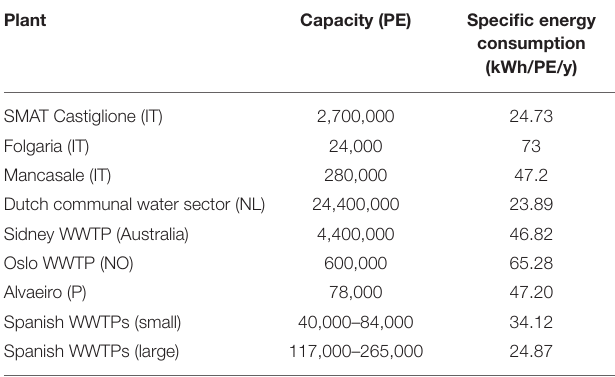
TABLE 2 | Analysis of WWTP energy consumption in relation with the plant capacity.